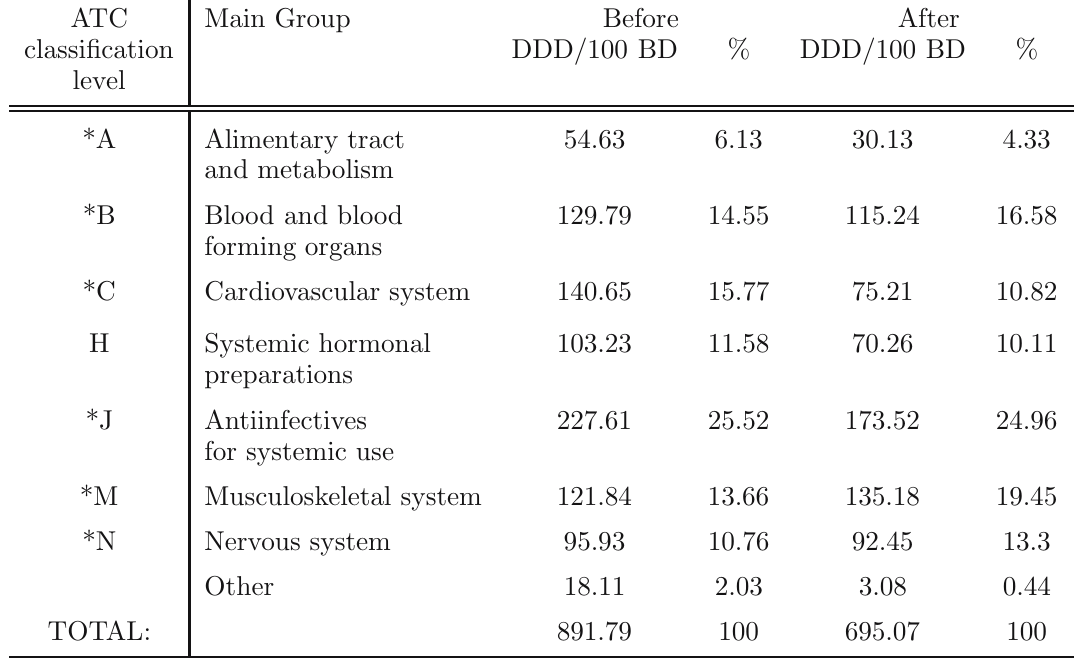
pedic ward, Department of Surgery, University Clinical Center,